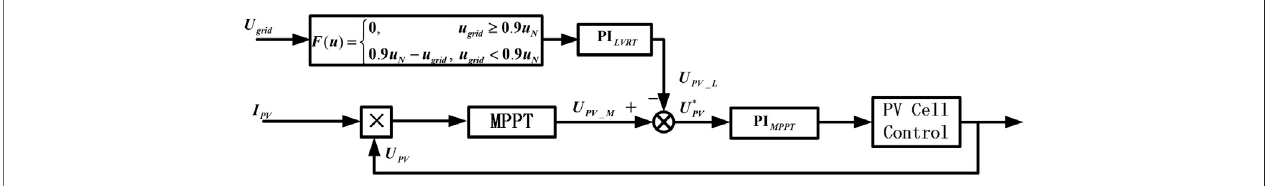
FIGURE 3 | Adaptive MPPT control structure